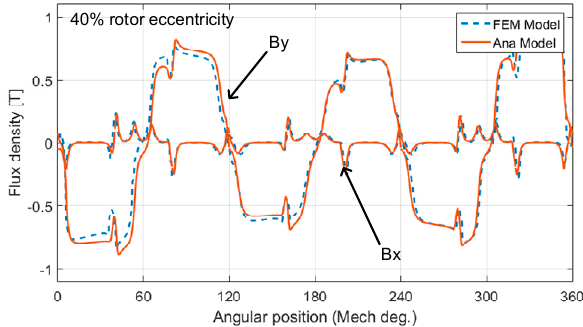
Figure 13. Axial and circumferential components of flux density at the air gap ( l = L − 1 mm) under rated-load condition.